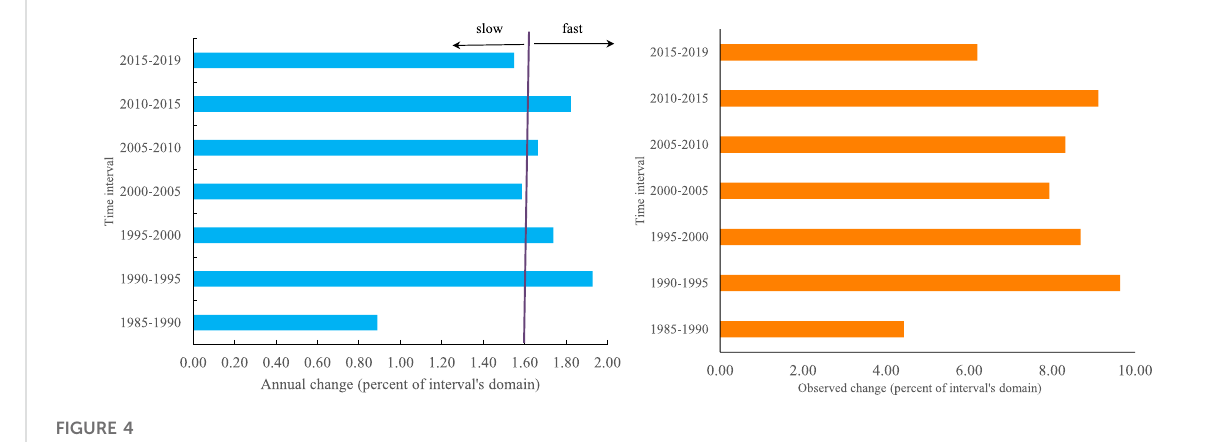
FIGURE 4 The interval level change of land use in Wujiang River Basin.